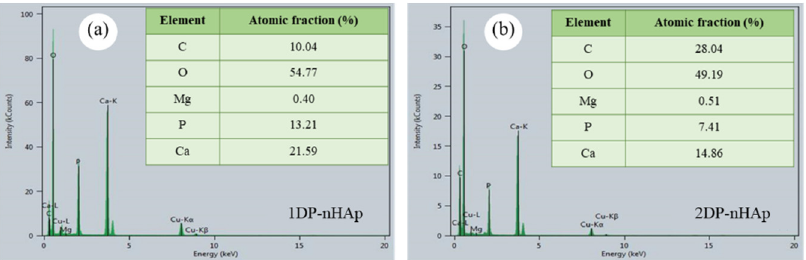
Figure 5. Results from elemental analysis by EDS of nHAp powder ( a ) 1DP − nHAp and ( b ) 2DP − nHAp.